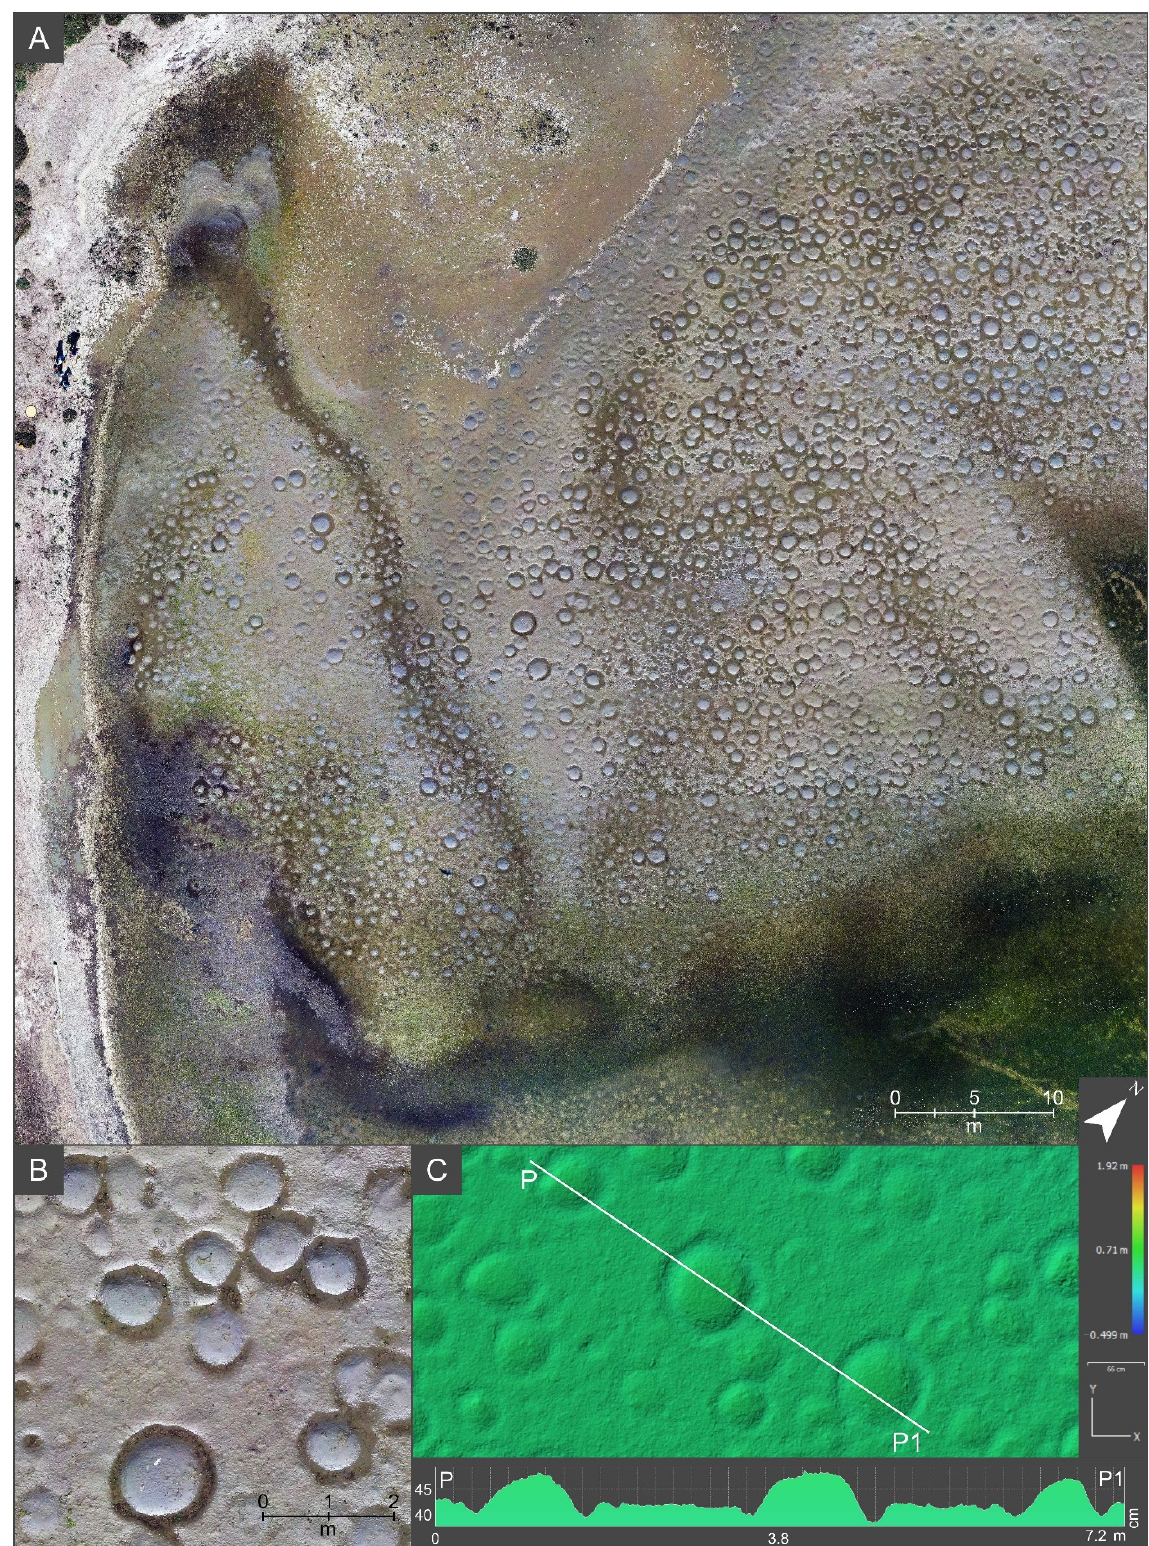
Figure 1. Pictures taken by an Unmanned Aerial Vehicle (UAV) of Greater Flamingo pit foraging bedforms in the back-barrier intertidal environment in the Marano-Grado Lagoon (Italy): ( A ) orthophoto of the sizeable pit aggregation field; ( B ) a close-up of the hi-res orthophoto; and ( C ) a close-up of the DTM (Digital Terrain Model) with a focus on an elevation profile.